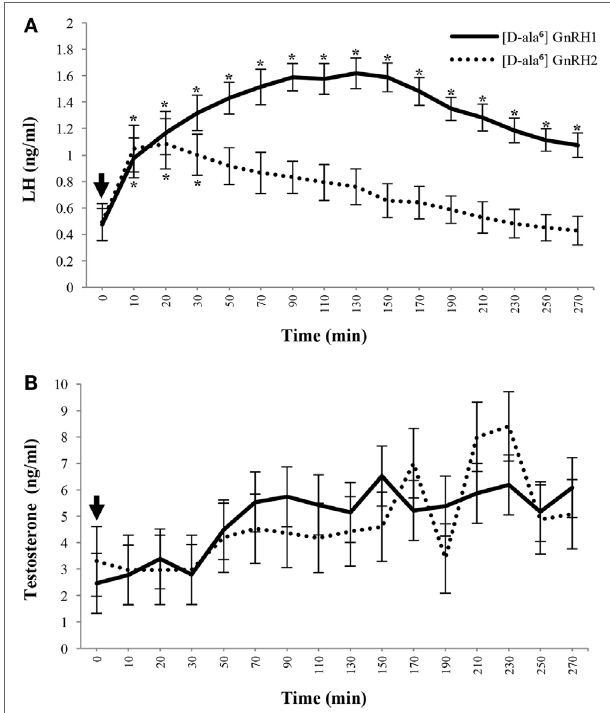
FiGURe 7 | GnRH2 stimulates secretion of testosterone similar to GnRH1 despite reduced luteinizing hormone (LH) release in mature male pigs. Plasma concentrations of LH (A) and testosterone (B) after intravenous administration of [ d -ala 6 ] GnRH1 (solid line; n = 8) or [ d -ala 6 ] GnRH2 (dotted line; n = 6) to cannulated adult males. After pretreatment sampling, treatments were administered (arrow; 0 min) and blood was serially collected. Data are presented as the Least Squares Means ( ± SEM). For LH, Treatment, P < 0.001; Time, P < 0.0001; Treatment × Time, P < 0.03. For testosterone, Treatment, P = 0.1929; Time, P < 0.002; Treatment × Time, P = 0.7190. *Within treatment, concentrations differ from pre-injection levels ( P < 0.05). GnRH1 differences are indicated above error bars and GnRH2 differences are labeled below error bars. Reprinted from Desaulniers et al. (35) with permission from Oxford University